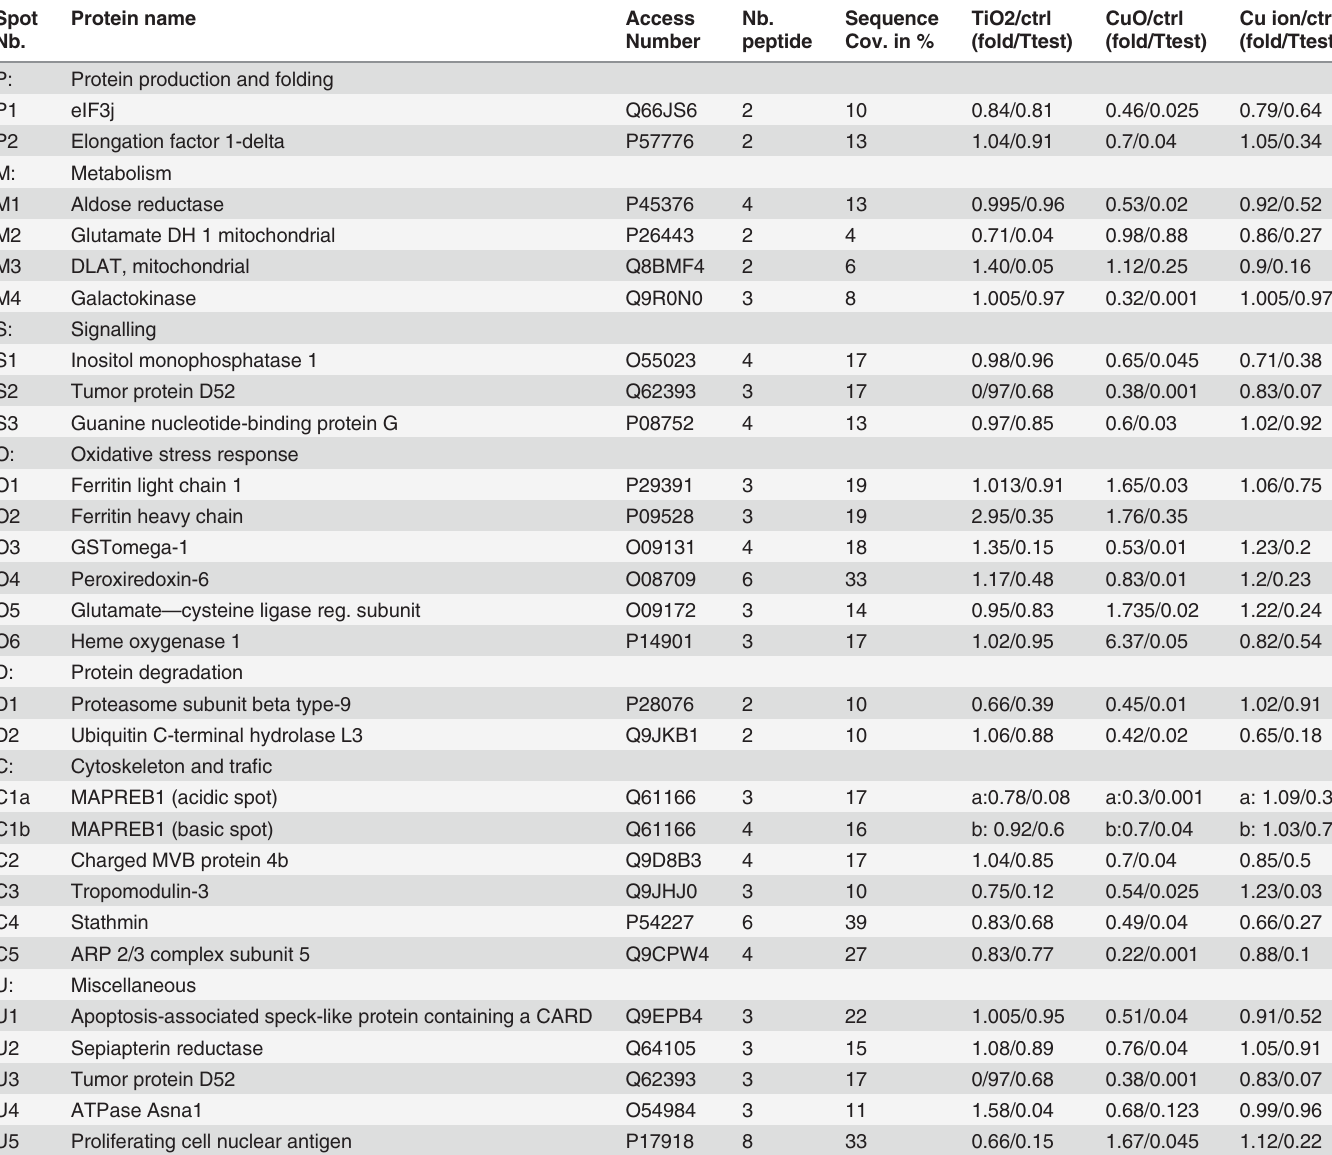
Table 3. Differentially-expressed proteins identified in the proteomic